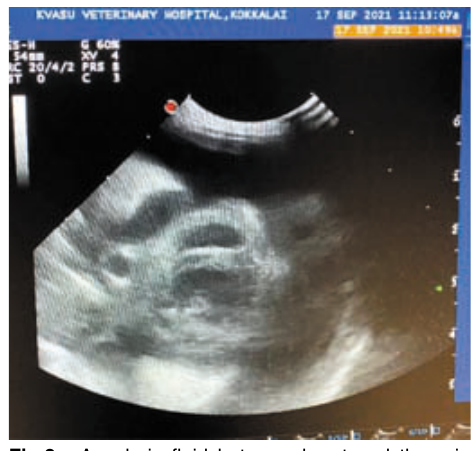
Fig.2: Anechoic fluid between heart and thoracic cavity revealed on thoracic ultrasonography